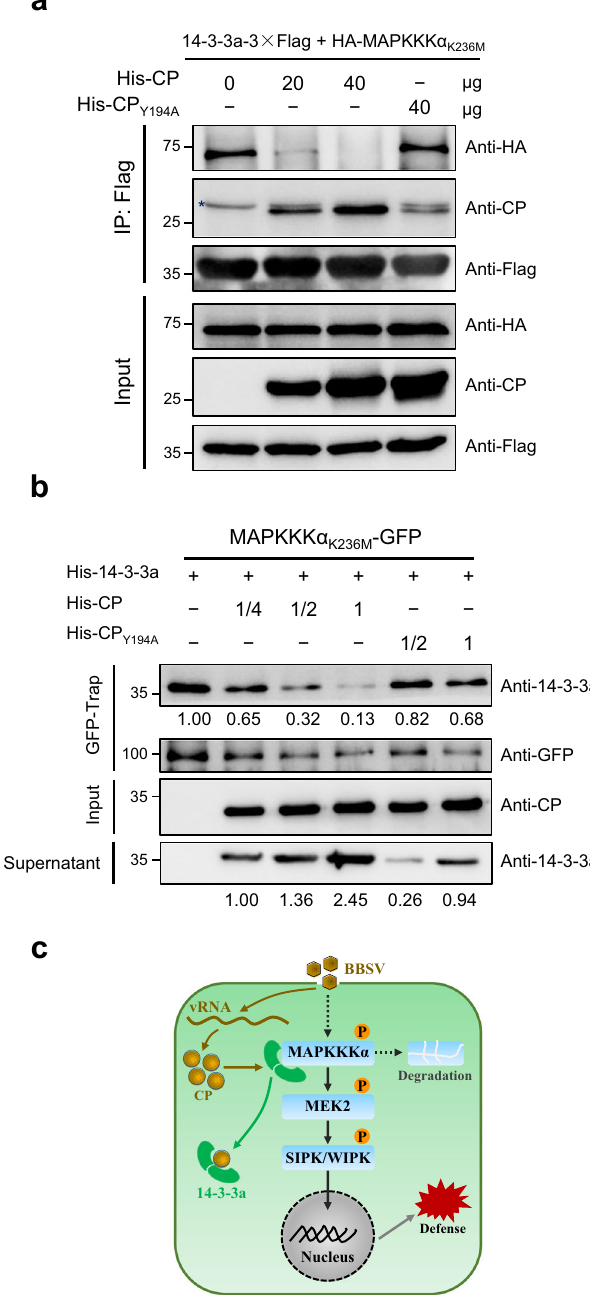
DNA virus that directly interacts with MAPKs and inactivates them to compromise defense responses 33 – 36 , BBSV CP does not